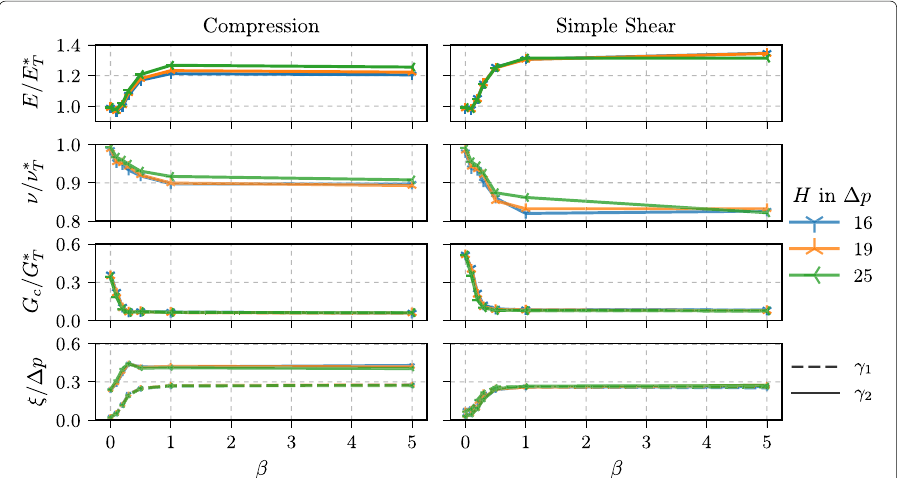
Fig. 4 Fitted material parameters; E and ν are normalized by the theoretical values for regular honeycombs, the coupling modulus G c is normalized by the theoretical shear modulus, and the internal lengths ξ i are given in units of the cell size; data for compression (left) and for simple shear